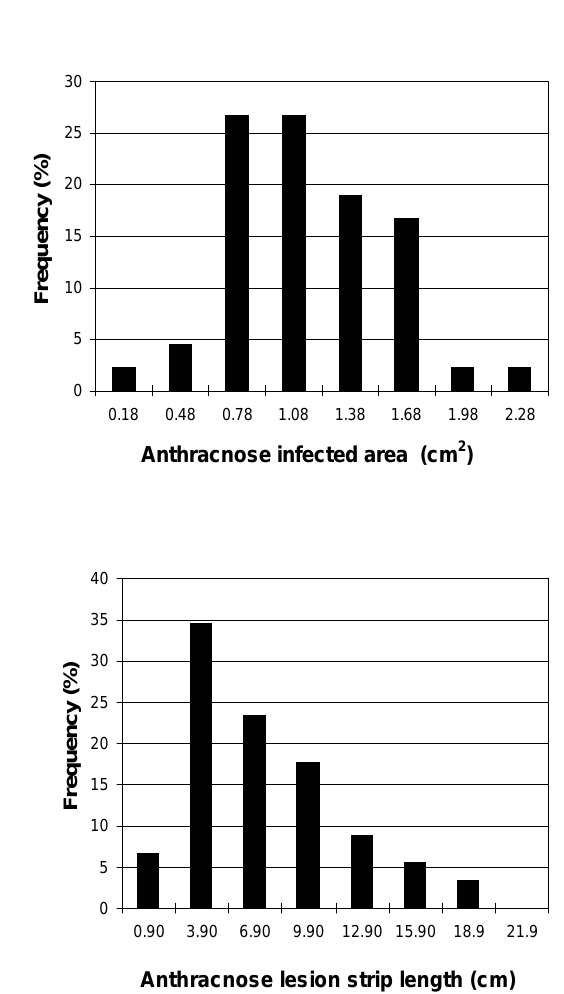
Figure 1 - Frequency distribution in the tested rubber tree population evalu- ated for anthracnose panel canker disease resistance for infected area and lesion strip length.